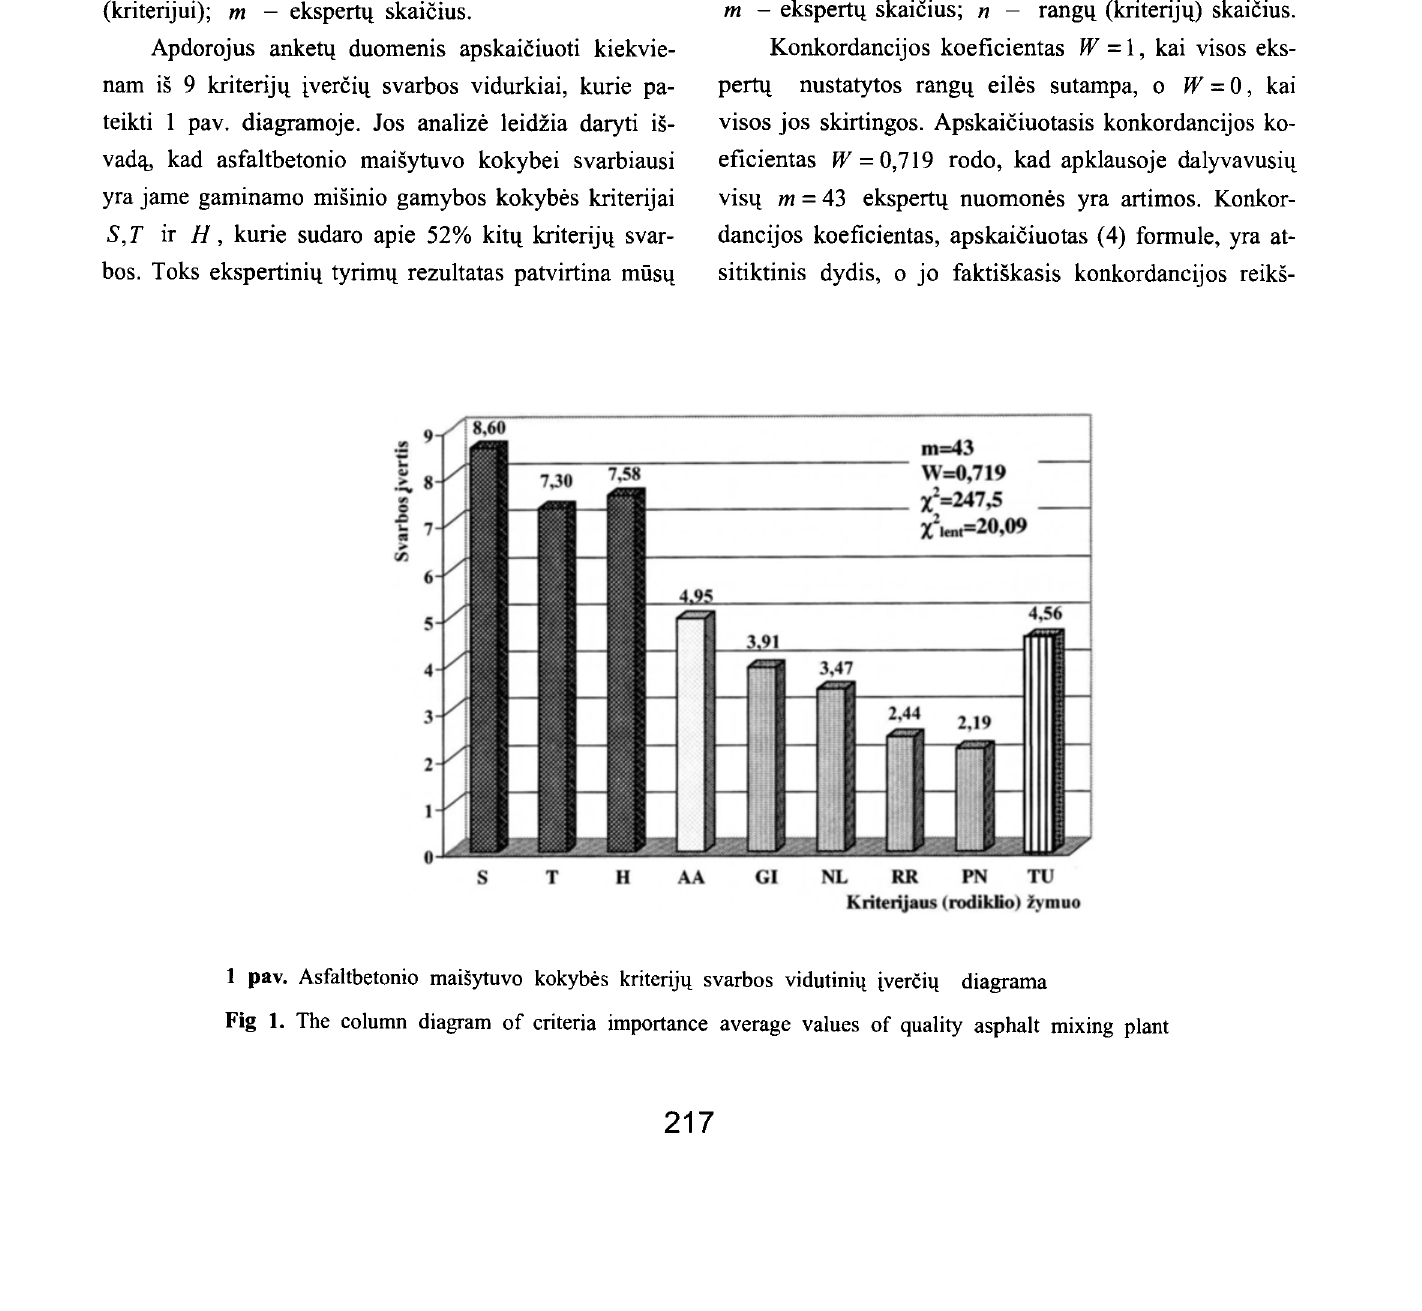
Fig 1. The column diagram of criteria importance average values of quality asphalt mixing plant